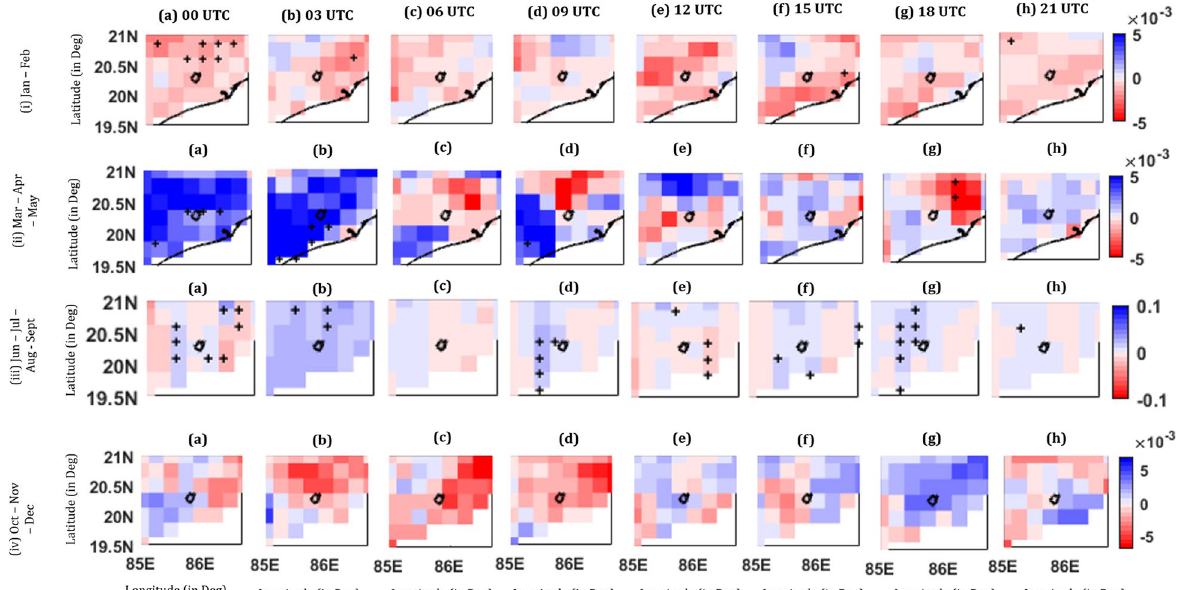
Fig. 7 Trend of 3-hourly rainfall during 1999–2018 year for (a) 00 UTC, (b) 03 UTC, (c) 06 UTC, (d) 09 UTC, (e) 12 UTC, (f) 15 UTC, (g)18 UTC, and (h) 21 UTC for (i) Jan – Feb, (ii) Mar-Apr-May, (iii) Jun-Jul-Aug-Sept, and (iv)Oct-Nov-Dec from TRMM gridded data (black colour figure represents Bhubaneswar city boundary and black